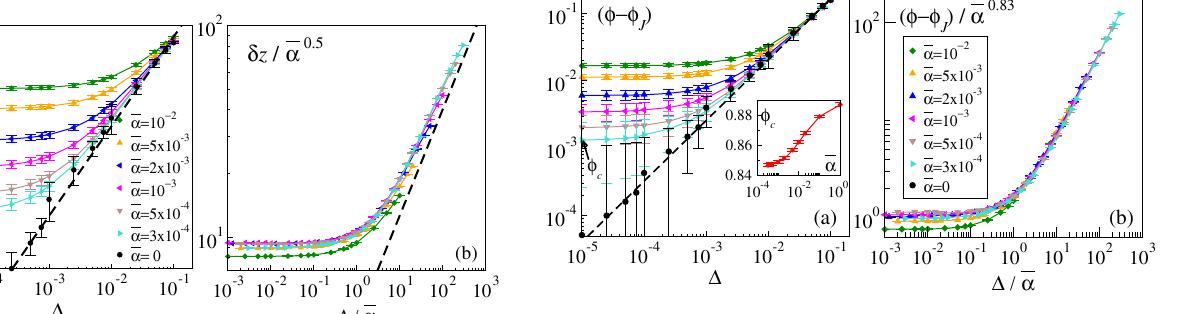
FIG. 3. (a) Log-log plot of ϕ − ϕ versus Δ for different J 0 . 8456 is defined as the packing fraction values of ¯ α . ϕ J ¼ for ¯ α ¼ 0 , and for the smallest pressure we simulate Δ ¼ 10 − 5 . Inset: ϕ versus ¯ α . ϕ is estimated by considering c c the packing fraction at Δ ¼ 10 − 5 . (b) Scaling collapse ≈ f ð Δ = ¯ α Þ ¯ α 0 . 83 showing that ϕ ð Δ Þ − ϕ J